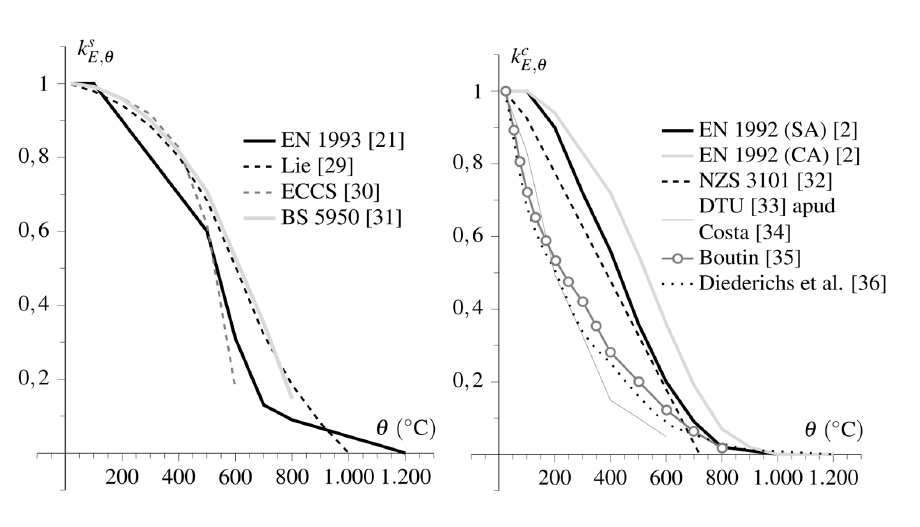
( ) c k θ as a function of E,